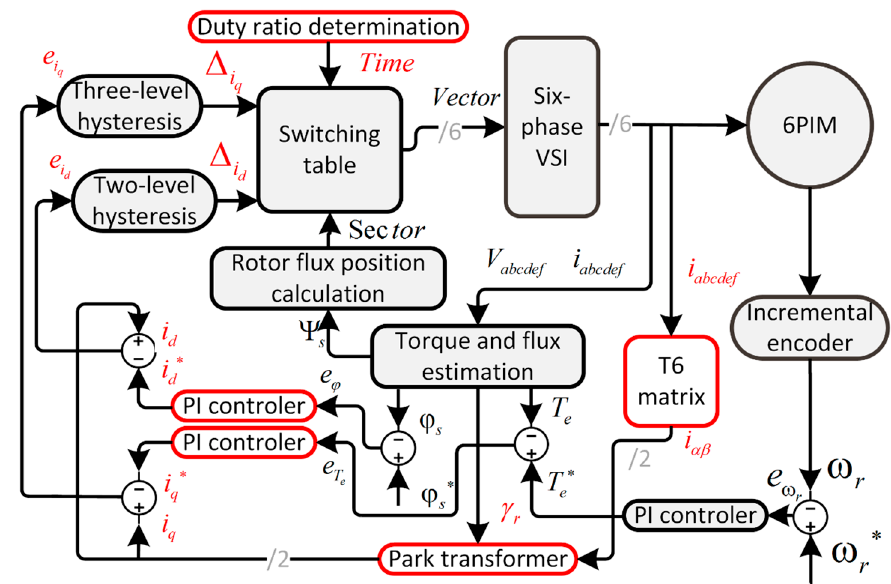
Figure 6. Block diagram of the proposed control scheme for 6PIM.